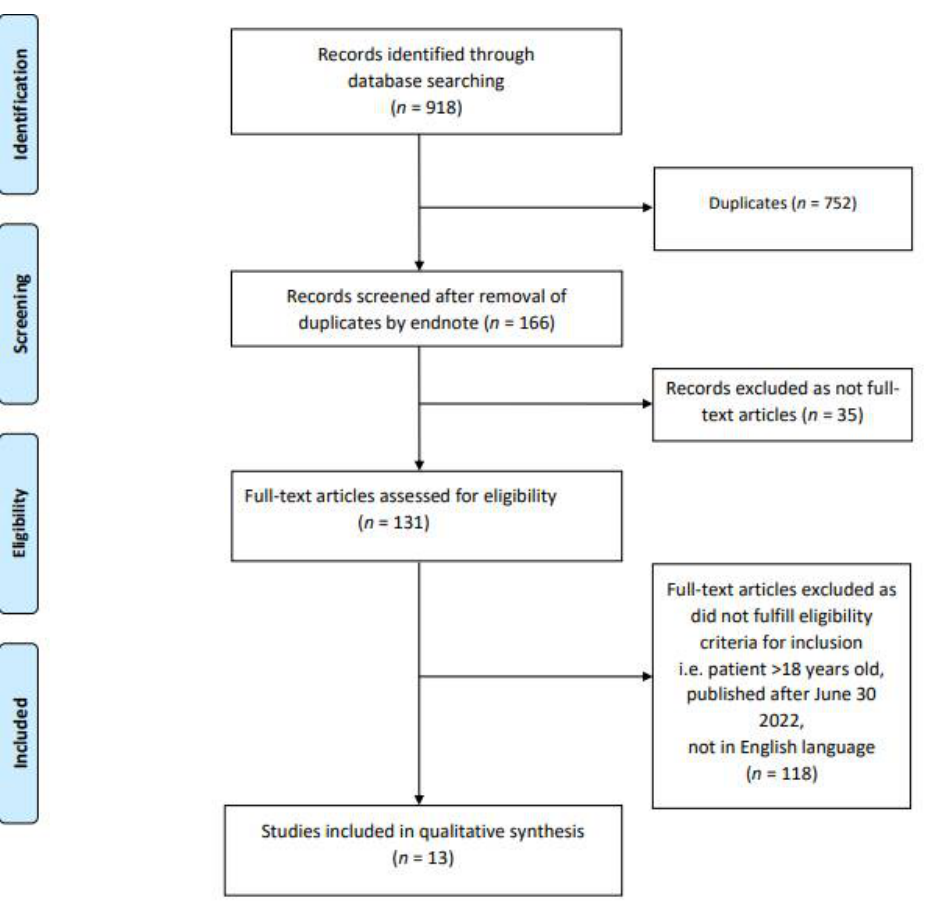
Figure 1. PRISMA Flow Diagram .